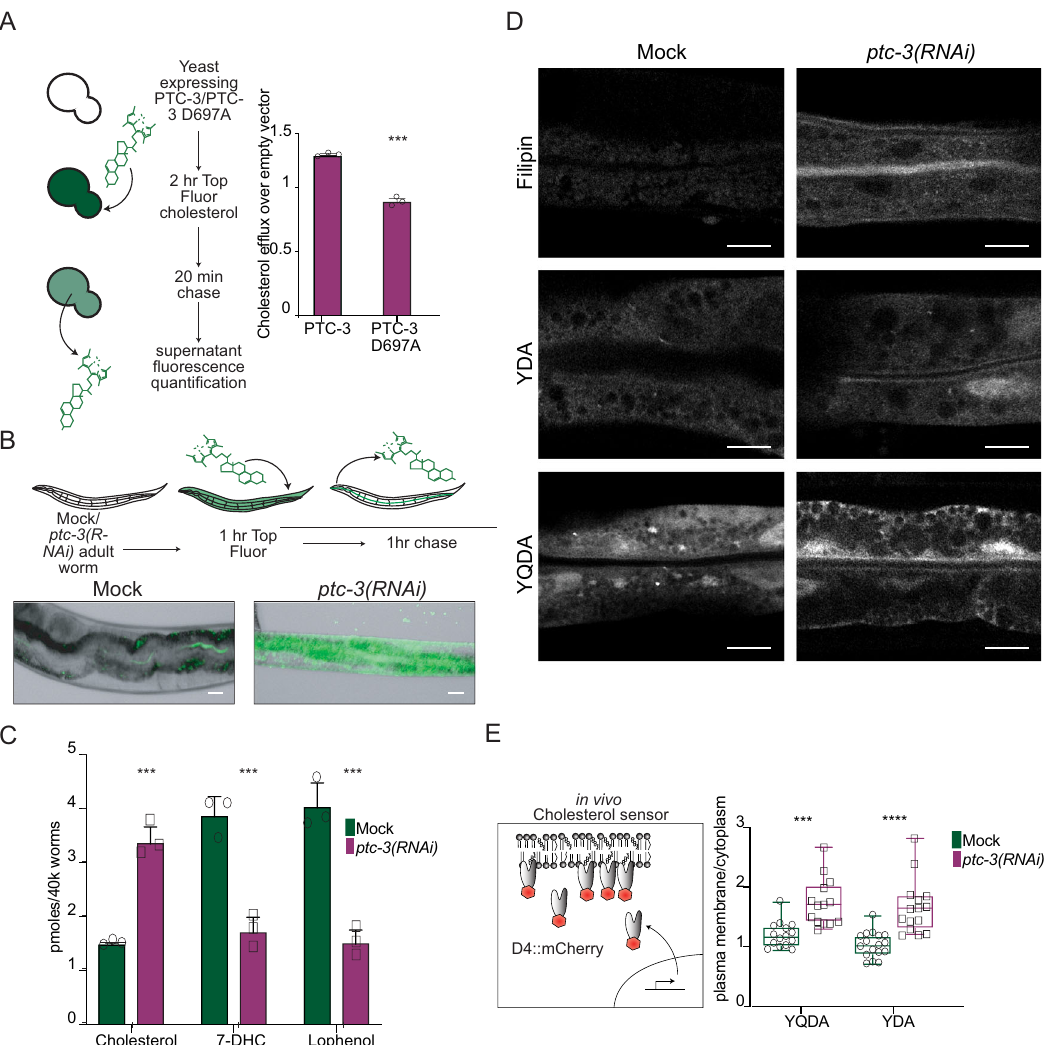
Fig. 2 PTC-3 is a cholesterol transporter. A S. cerevisiae expressing PTC-3 or PTC-3 D697A were incubated for 2 h with 5 mM TopFluor ® Cholesterol, washed, re-suspended in cholesterol-free buffer, and after 20 min, fl uorescence intensity of the supernatant was measured. PTC-3 expression induced cholesterol ef fl ux from yeast, which was abolished by the D697A mutation. Mean and SD error bars. Unpaired two- tailed T test *** p = 0.000066 n = 3. B N2 adult worms fed with mock or ptc-3(RNAi) after L2 stage were incubated with 2.5 mM TopFluor ® Cholesterol for 1 h. After 1 h chase, animals were imaged. Scale bar 10 µ m. n = 12 (mock) and 16 ( ptc-3(RNAi )) animals from three independent experiments. C Cholesterol accumulates in animals fed with ptc-3(RNAi) after L2 stage. Quanti fi cation of sterols by MS. Mean and SEM error bars n = 3. One-way ANOVA *** p = 0.0003. D Cholesterol identi fi cation by Filipin or mutagenized YDA or YQDA D4::mCherry cholesterol sensor in the adult intestine in mock or ptc-3(RNAi) treated animals after L2 stage. ptc-3 (RNAi) induces membranal cholesterol accumulation in the intestinal apical membrane. Scale bars 10 µ m. E Quanti fi cation of apical membrane enrichment over cytoplasm of the cholesterol sensors YDA or YQDA D4::mCherry. Whiskers represent min and max, center represents mean and SD *** unpaired two-tailed T test; p = 0.000047 and 0.00002 n = 15 (YQDA mock), 14 (YQDA ptc-3(RNAi )), 17 (YDA mock) and 15 (YDA ptc-3(RNAi )) animals. Statistical source data are available as source